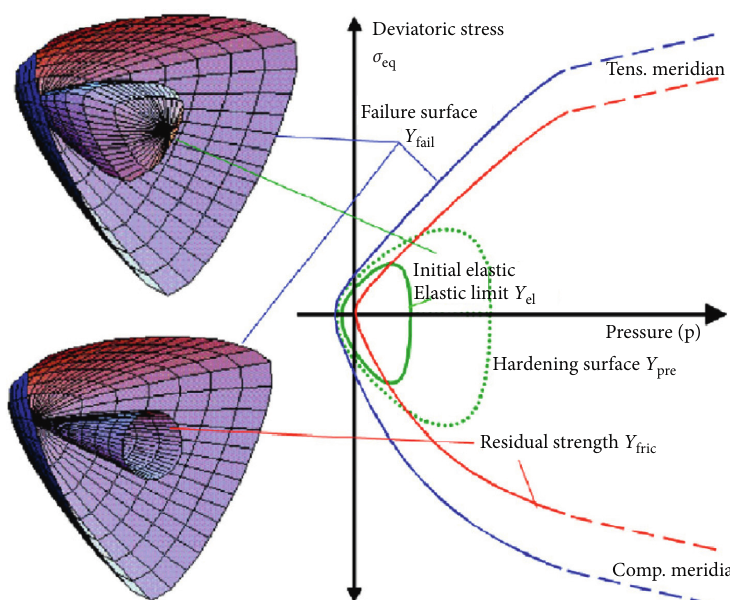
Figure 1: Schematic diagram of elastic limit surface, failure surface, and residual strength surface of the RHT model.